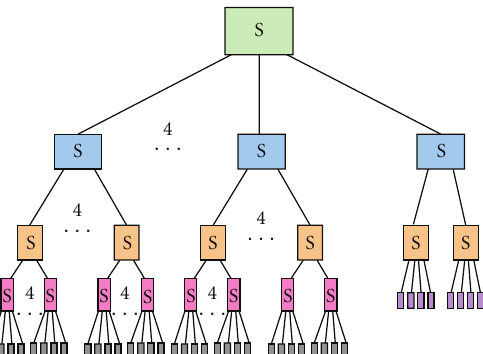
Figure 7: Symmetric tree-based heterogeneous FPGA architecture.